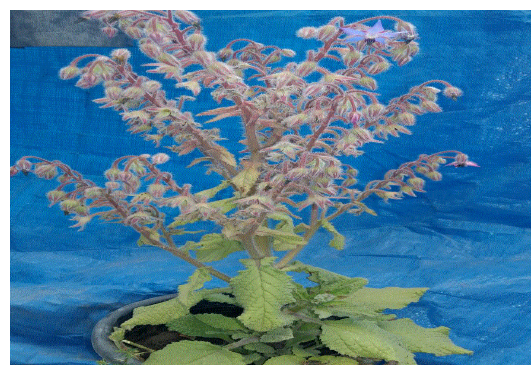
Figure 1. Borago officinal plant cultivated in Iraq . (12)